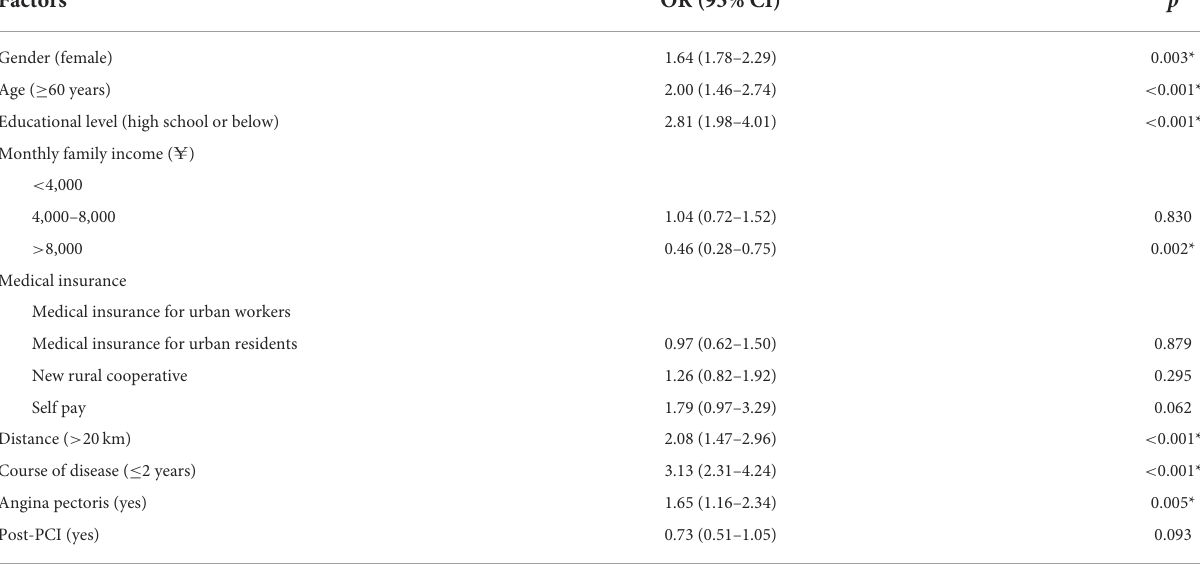
TABLE 2 Factors associated with EECP adherence after